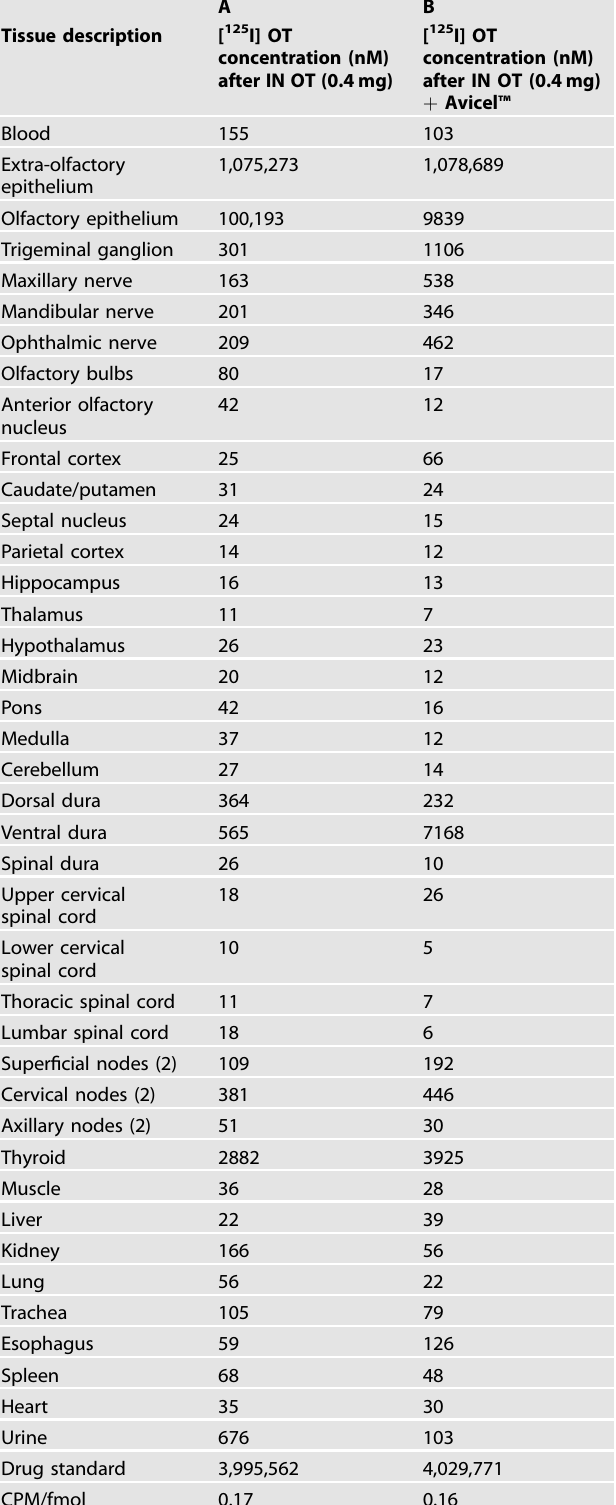
Table 3. Gamma Counts representing [125I]oxytocin (OT) concentration 60 min after intranasal administration of [125I]OT: (A) 0.4 mg and (B) 0.4 mg with Avicel ® ™ mucoadhesive (one rat per condition; CPM = counts per